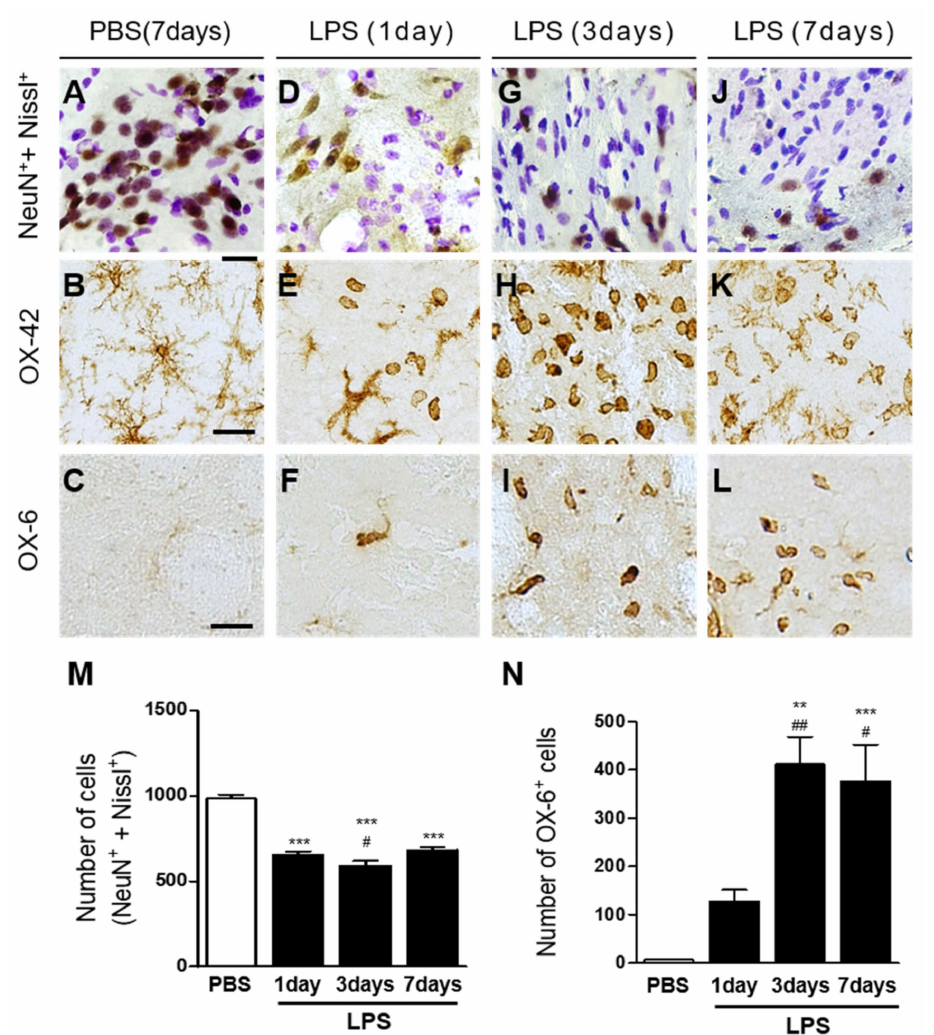
Figure 1. LPS induces neurodegeneration and microglial activation in the rat striatum in vivo. Animals unilaterally received injection of phosphate-buffered saline (PBS) ( A – C ) as a control or lipopolysaccharide (LPS; ( D – L ); 5 µ g/3 µ L) into the rat striatum and were transcardially perfused at indicated time points. The brain tissues were processed for Nissl staining ( A , D , G , J ) and immunohisto- chemical staining with NeuN (neuronal nuclei) and Nissl costaining ( A , D , G , J ) or OX-42 (complement receptor3, CR3; ( B , E , H , K )) to identify microglia/macrophages, or OX-6 (major histocompatibility com- plex class II; ( C , F , I , L )) to identify activated microglia at 1 day ( D – F ), 3 days ( G – I ), and 7 days ( J – L ) af- ter intrastriatal injection of LPS. Scale bars, 20 µ m ( A , D , G , J ), 25 µ m ( B , C , E , F , H , I , K , L ). ( M ) Quantifica- tion of NeuN + and Nissl + cells in the LPS-injected striatum (Total area = 4.6 × 10 5 µ m 2 ). *** p < 0.001, significantly different from PBS (control). Data are presented as the mean ± SEM; n of animals = 4 to 5 in each group, ANOVA with Newman–Keuls analysis. ( N ) Quantification of OX-6 + cells in the LPS-injected striatum (total area = 4.6 × 10 5 µ m 2 ). ** p < 0.01, significantly different from PBS (control). *** p < 0.001, significantly different from PBS (control). ## p < 0.01, significantly different from LPS 1 day. # p < 0.05, significantly different from LPS 1 day. Data are presented as the mean ± SEM; n